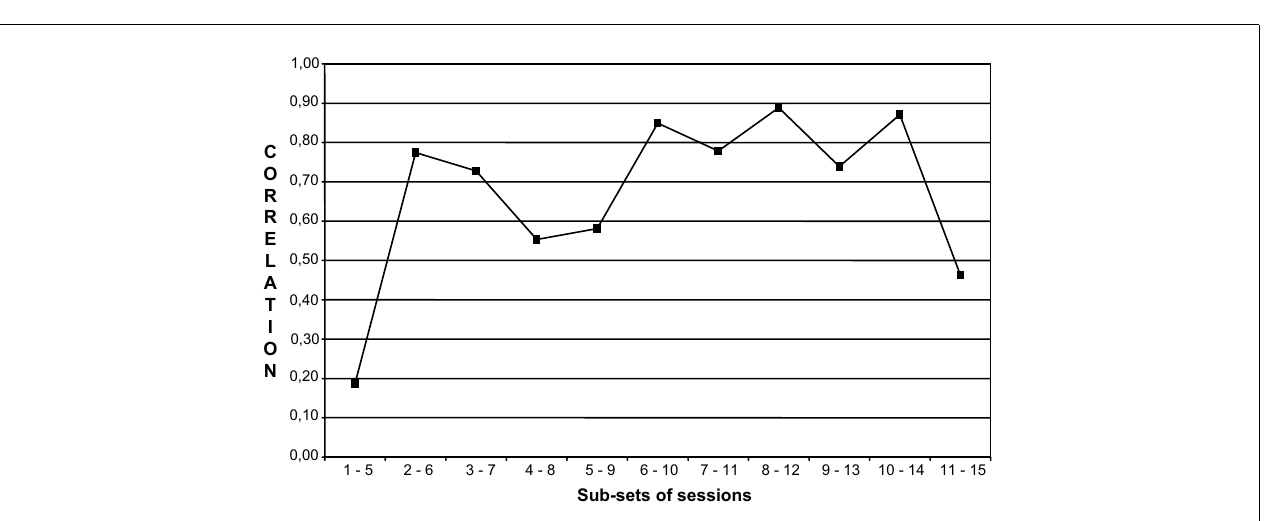
FIGURE 3 | Correlation between activity and super-order nodes (DFA indexes) within five session subsets from Salvatore et al. (2009).